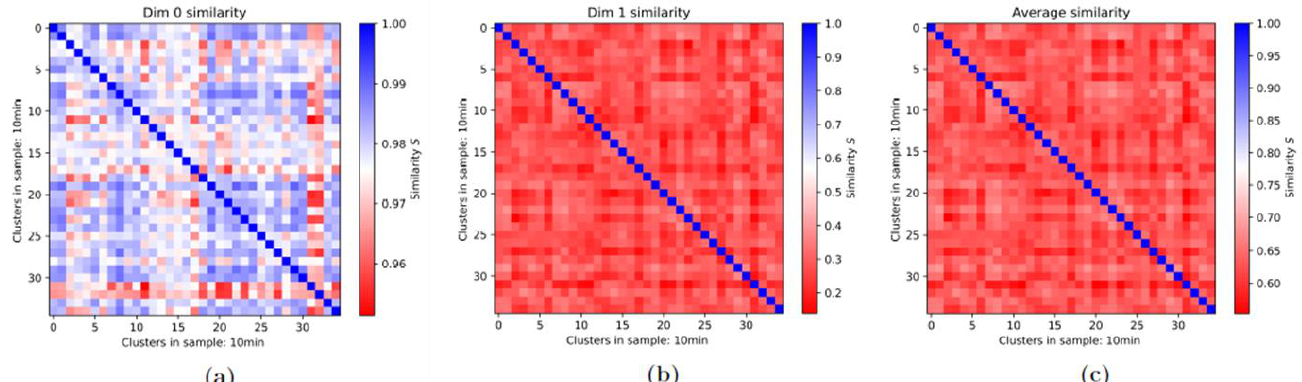
Figure 4. Example of the three 1st-generation heatmaps of γ H2AX clusters compared with each other for the control group of the MCF-7 cell line (10 min values). ( a ) The cluster similarities of the components (dim 0), ( b ) those of the holes (dim 1), and ( c ) the average values for each of the pixels from ( a ) and ( b ) are presented. Note: This example is shown because the differences in the similarity of components and holes is large. In the dim 0 heatmap, many clusters have a similarity of above 0.98 and the lowest values are around 0.96. In contrast, in the dim 1 heatmap, the highest value is at about 0.6 and practically all values are in the range of 0.2 to 0.6, excluding the diagonal ones (identity). Therefore, the average is dominated by the dim 1 values. Moreover, the problematic effect of the diagonal can be seen quite effectively as the range of values can only be observed up to a certain degree of accuracy. The differences between the colors for a relatively large spectrum of values are hardly recognizable.